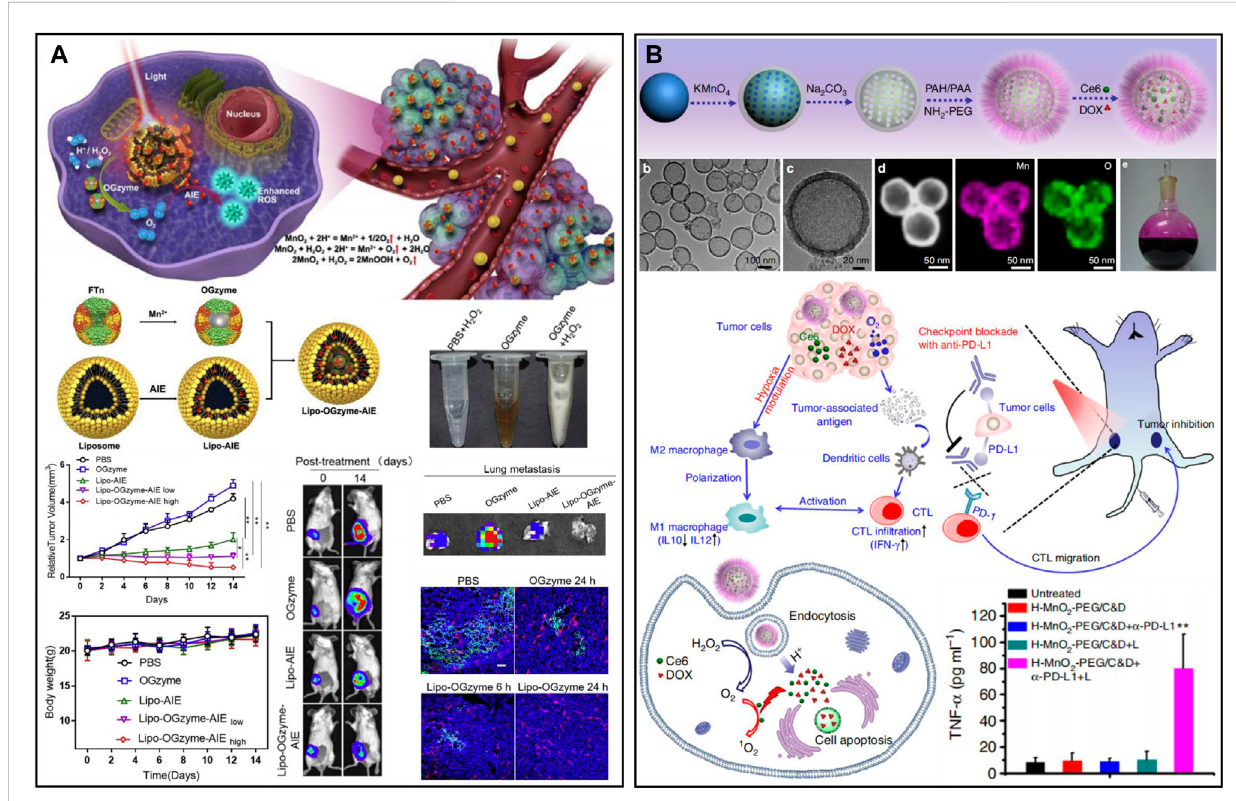
FIGURE 4 (A) A response cascade theranostic nanosystem (Lipo-OGzyme-AIE) for photodynamic therapy. Reproduced from ref. (Liu et al., 2020a)